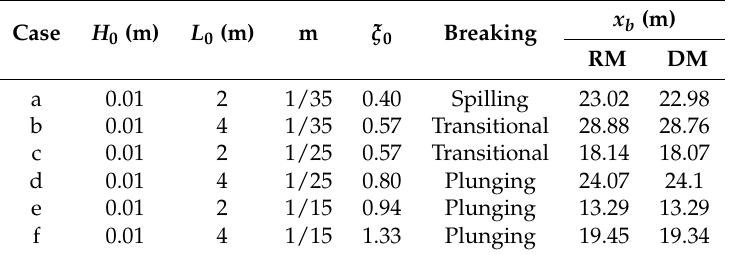
Table 3. Tested wave conditions.